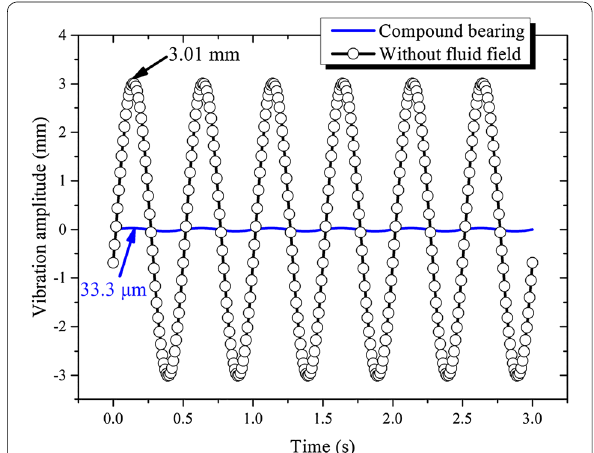
Figure 15 Vibration amplitude of the superconducting compound bearing